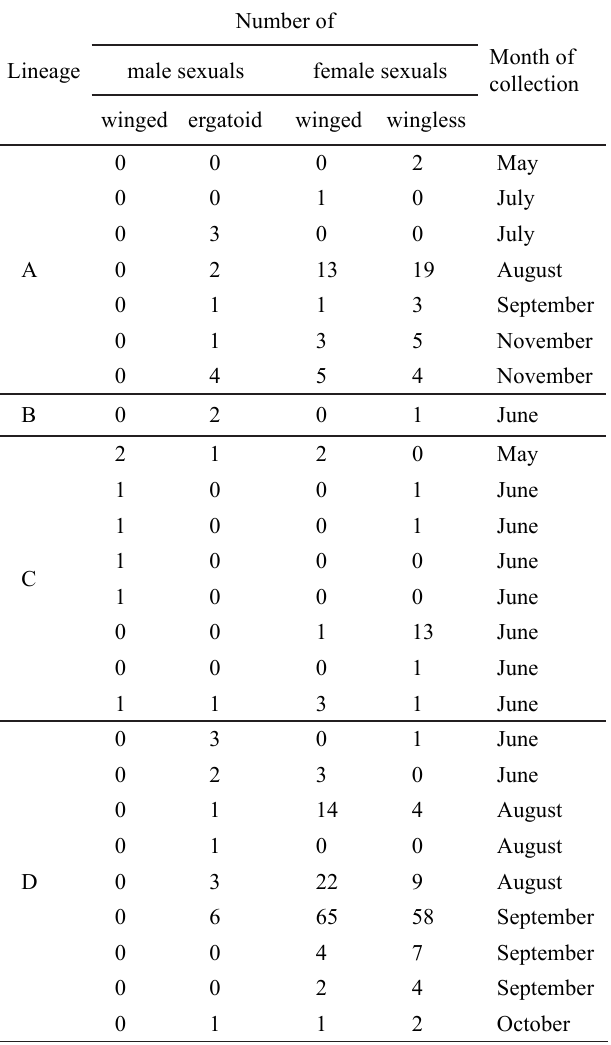
Table 6. Number of sexuals present in 24 field colonies of Car- diocondyla sl. kagutsuchi in Japan. We counted the number only if collected colonies contained sexuals. Four colonies did not have any female sexuals, possibly due to incomplete sample collection.